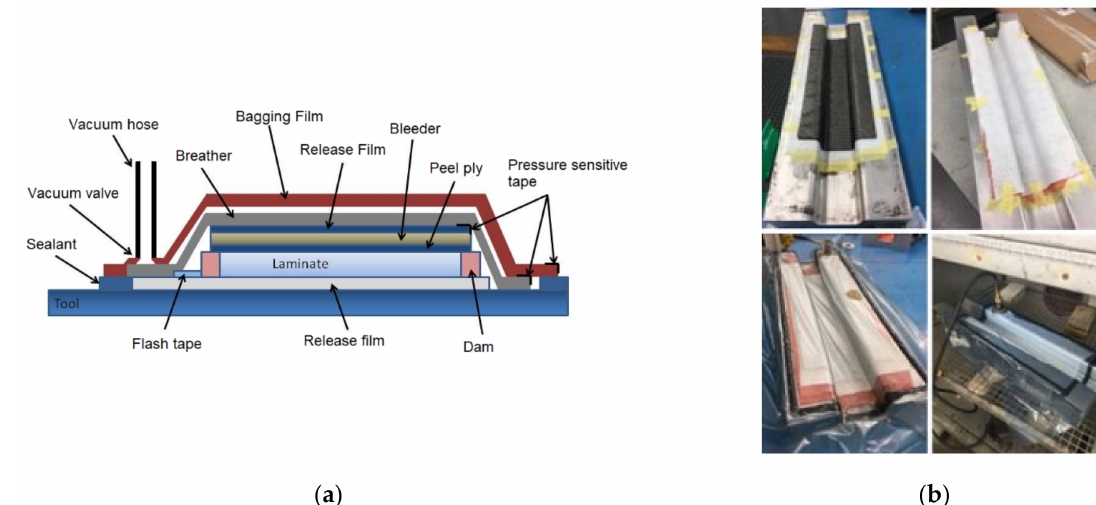
Figure 2. ( a ) Detailed description of the vacuum bagging process (image source: “Vacuum bagging” by CORE-Materials is licensed with CC BY-NC-SA 2.0), ( b ) execution of bagging process in this